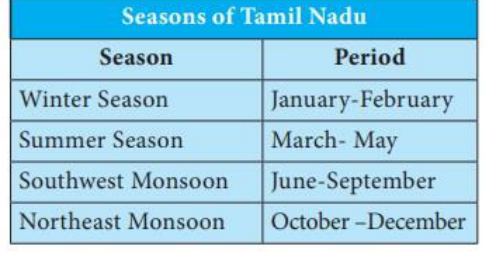
Table 1: Seasons of Tamil